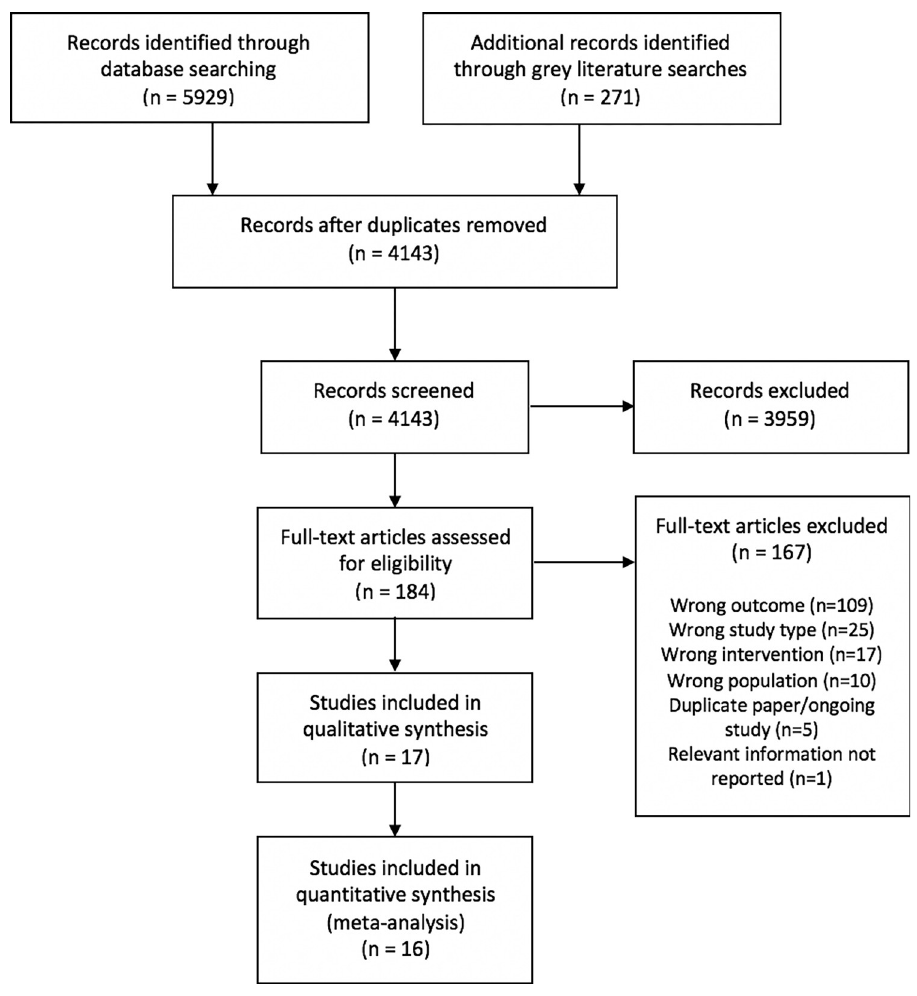
Fig 1. PRISMA-flowchart of search process